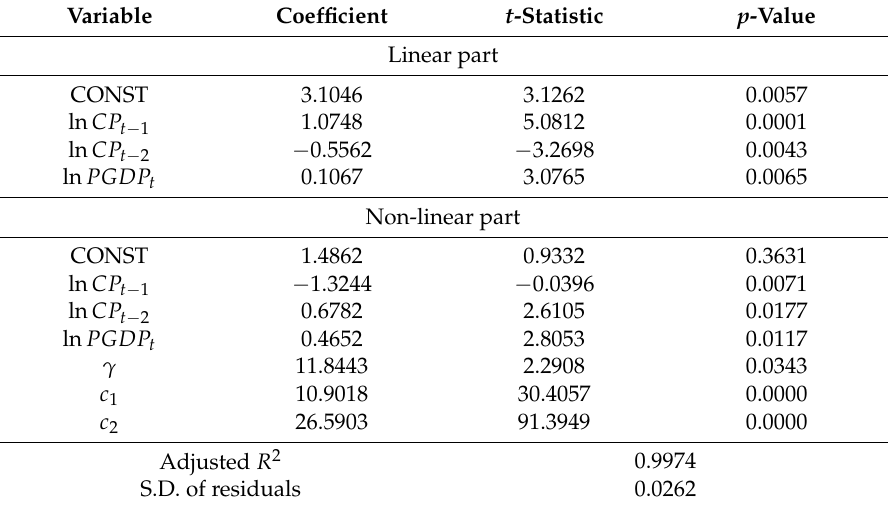
Table 8. LSTR2 model estimation